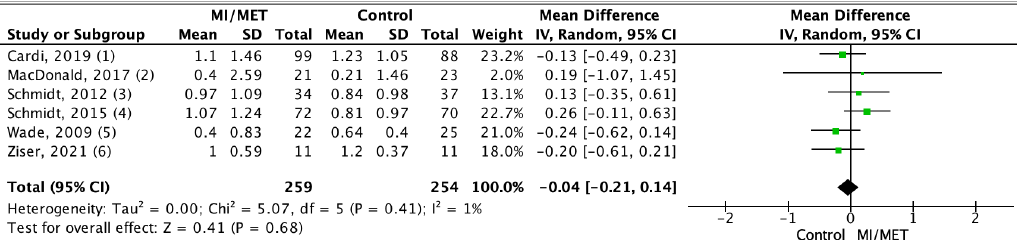
Figure 5. Forest plot displaying the pooled effect using SMD of MET/MI on eating disorder psycho- pathology (EDP). Mean = mean change in EDP scores from baseline to follow-up.